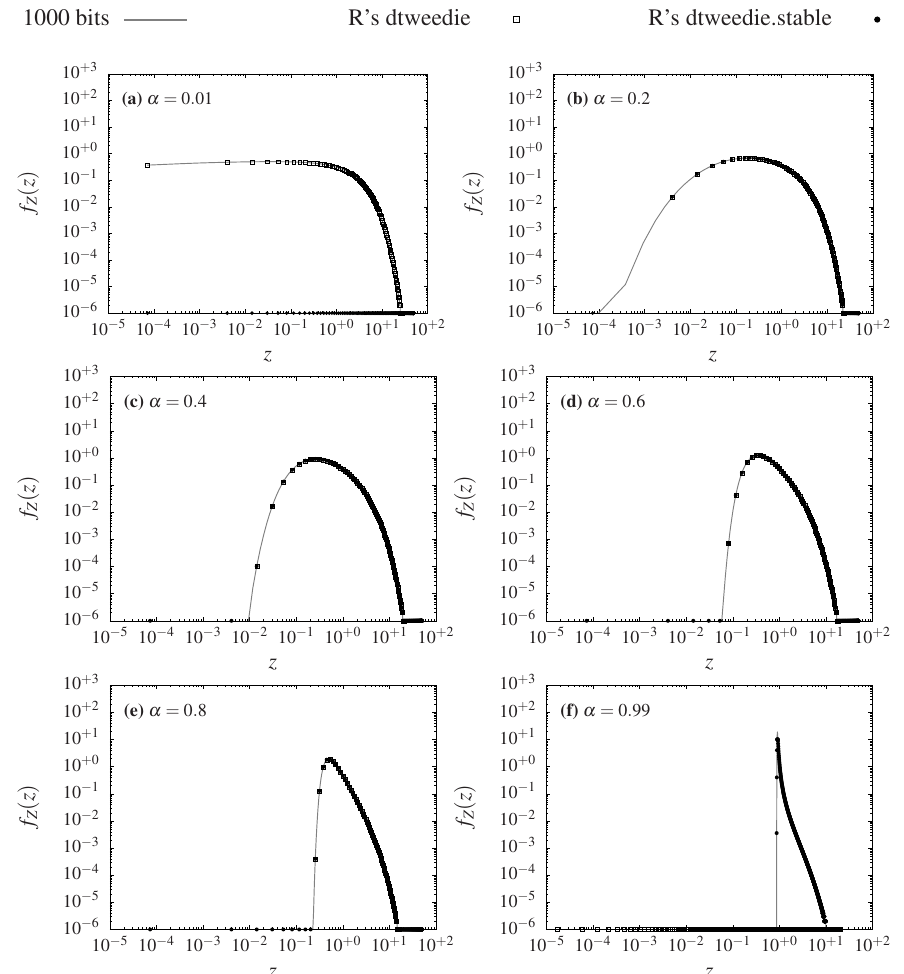
Figure 6 - Detailed verification of the convergence behavior of 1000-bit densities “np-nl” (continuous gray line), in comparison with dtweedie (open squares) and dtweedie.stable (filled circles): ( a ), α = 0.01 ; ( b ), α = 0.2 ; ( c ), α = 0.4 ; ( d ), α = 0.64 ; ( e ), α = 0.8 and ( f ), α = 0.99 . In (a) , dtweedie.stable values lower than 1.0 × 10 –6 are shown at this value. In (e) , dtweedie values lower than 1.0 × 10 –6 are shown at this